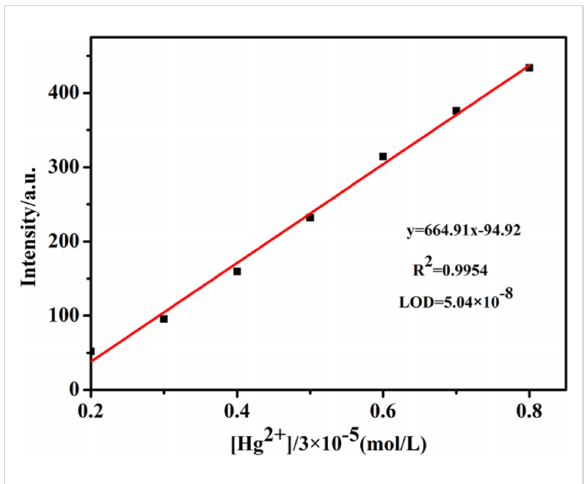
Figure 4: The standard Job curve of mercury ions to OST ( c = 3.0 × 10 − 5 mol ∙ L − 1 ) at 406 nm (pH 7.0, H 2 O/CH 3 OH 97:3, v/v, λ ex = 325 nm).